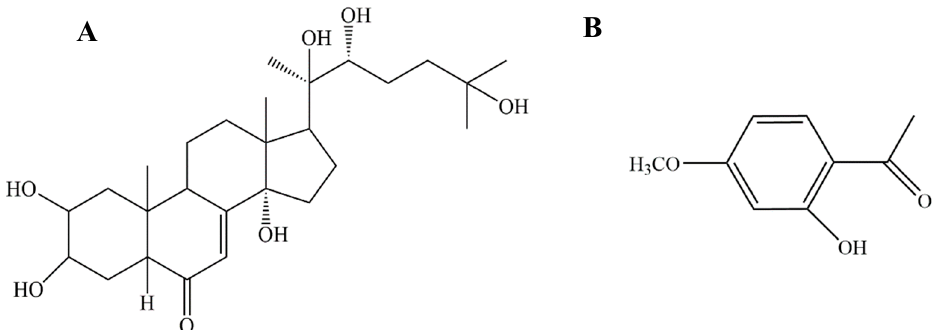
Figure 1. Chemical structures of Ecdysterone and Paeonol: ( A ) Ecdysterone is a steroid derived from Achyranthes bidentata , a species of plant in the amaranth family; ( B ) Paeonol is a compound derived from Cortex Moutan , a species of plant in the Ranunculaceae family.